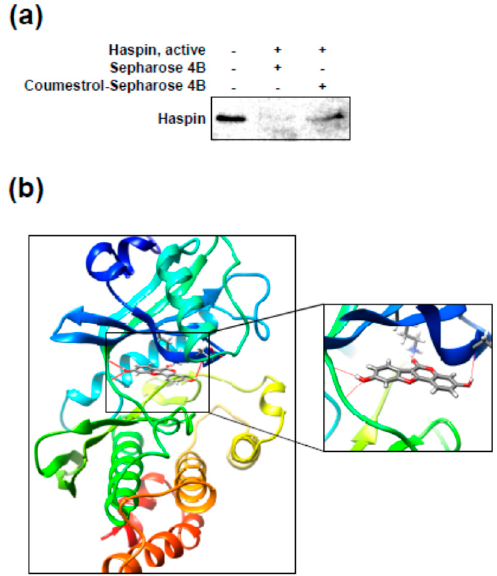
Figure 5. Coumestrol directly binds with haspin kinase. ( a ) Evidence for a direct interaction between coumestrol and recombinant haspin kinase. The binding was confirmed with a pull-down assay as described in the Materials and Methods. Data are representative of three independent experiments, which gave similar results; and ( b ) Modeling of coumestrol with haspin kinase. The modeling results were obtained using Schrödinger Suite 2015.